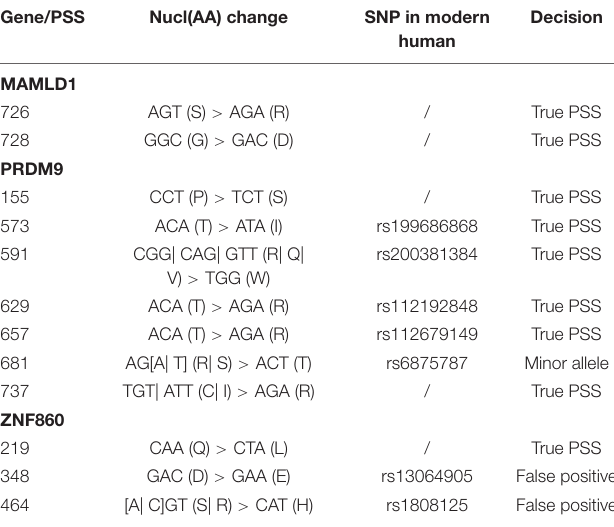
TABLE 2 | The 11 positively selected codons (PSS) within three genes with positive selection in the human branch that were detected by BEB and MEME, along with the respective nucleotide and amino acid (in brackets)